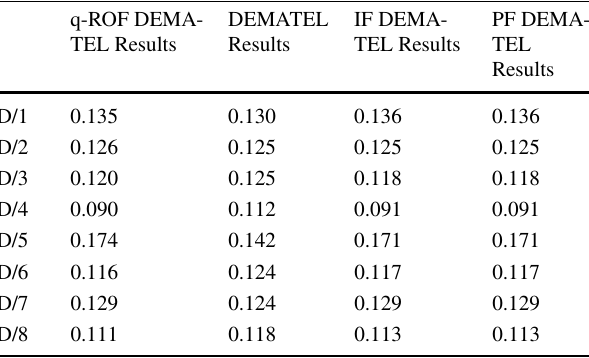
Table 9 Weighting Results q-ROF DEMA- TEL Results